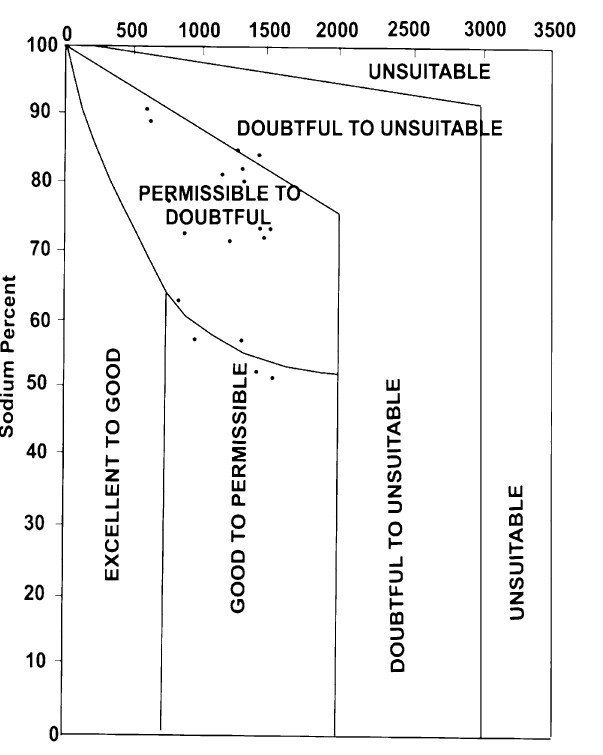
Fig. 10 The Wilcox diagram of water